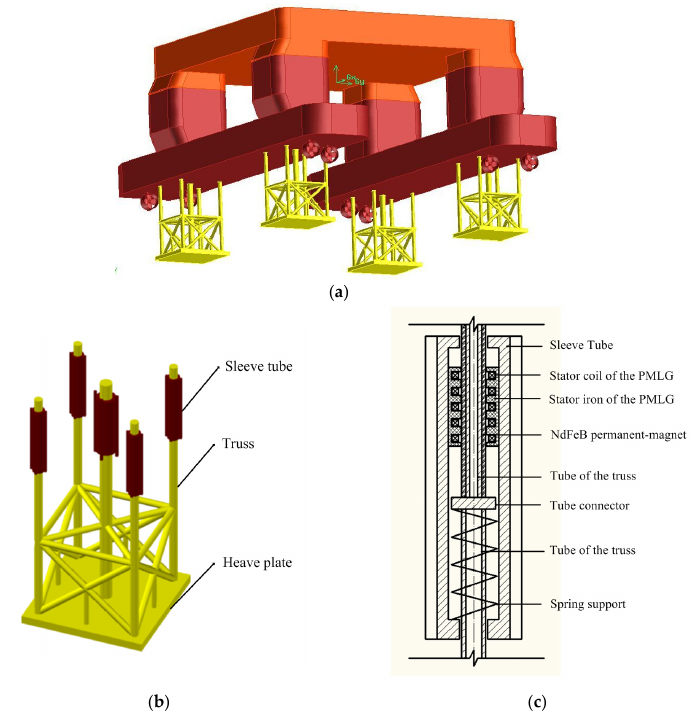
Figure 1. ( a ) The illustration of the semi ‐ submersible platform with the tuned heave plate energy harvesting system; ( b ) the illustration of a truss ‐ plate structure of the THPEH system; ( c ) the diagram of the connection structure in the sleeve tube.